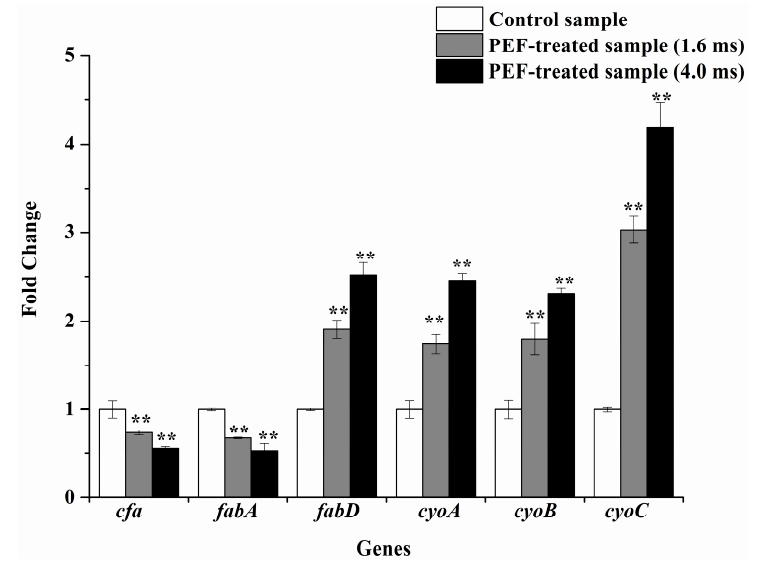
Figure 5. The effect of PEF treatment at 25 kV/cm on the expression of cfa , fabA , fabD , cyoA , cyoB , and cyoC genes of S. typhimurium (** p < 0.01).